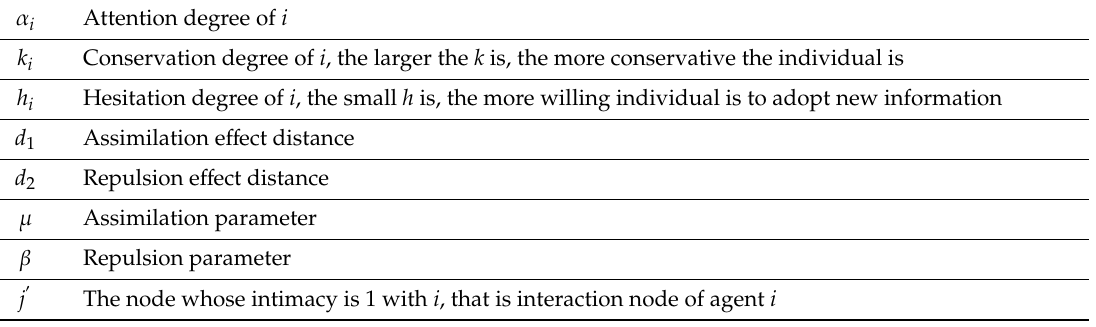
Table 1. Parameters involved in the model.